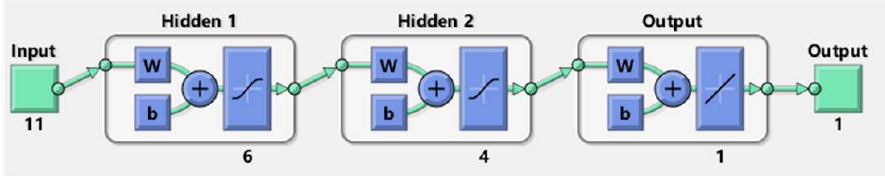
Figure 2. The structure of the proposed ANN.